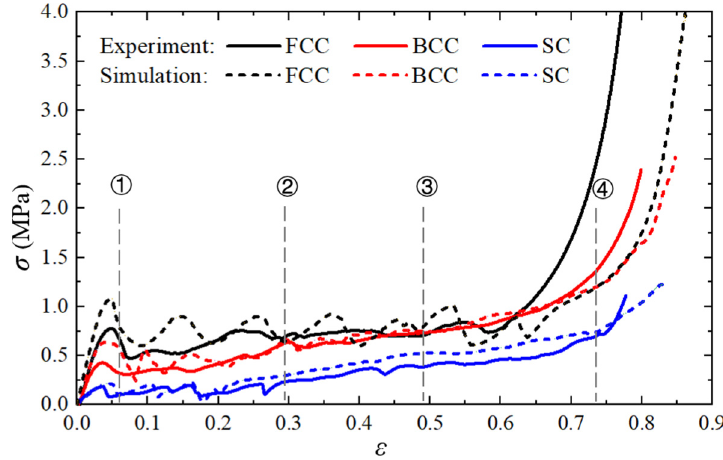
Figure 4. Nominal stress–strain curves of different structures.